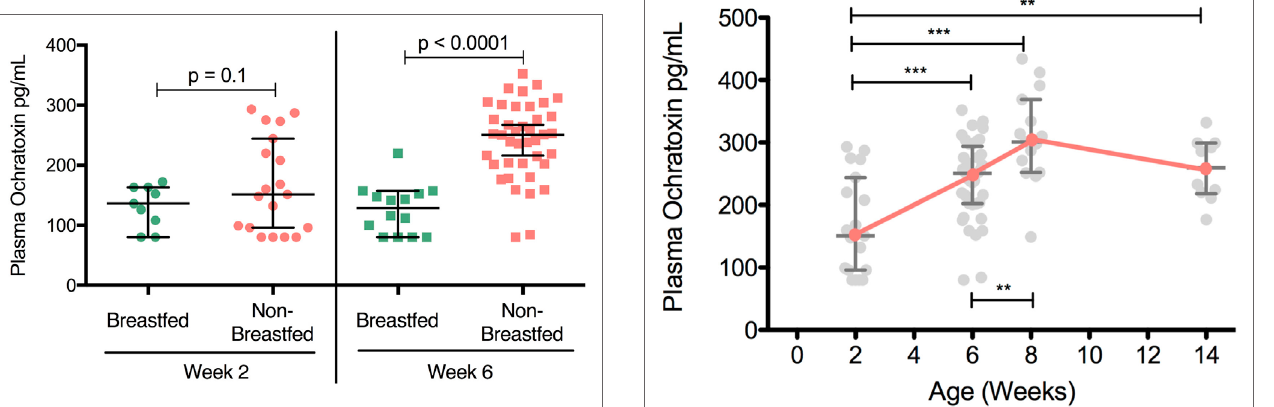
FigUre 2 | Plasma ochratoxin A (OTA) increases over the first 8 weeks of life in non-breastfed, South African infants. Plasma OTA levels in non-breastfed infants were assessed in 2-week-old ( n = 19), 6-week-old ( n = 40), 8-week-old ( n = 15), and 14-week-old ( n = 11) infants. Pairwise comparisons were tested with a Student’s t -test. All comparisons with a p -value less than 0.05 are shown above. Median and interquartile range are plotted for each time point. *** p < 0.001, ** p < 0.01, * p < 0.05. All infants were HIV-exposed.